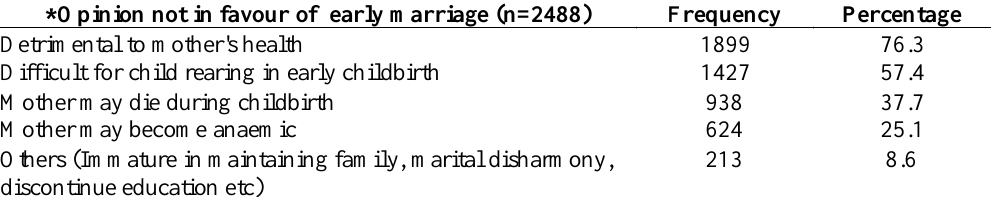
Table V : Adolescent’s knowledge on legal age at marriage Knowledge on legal age at marriage for female